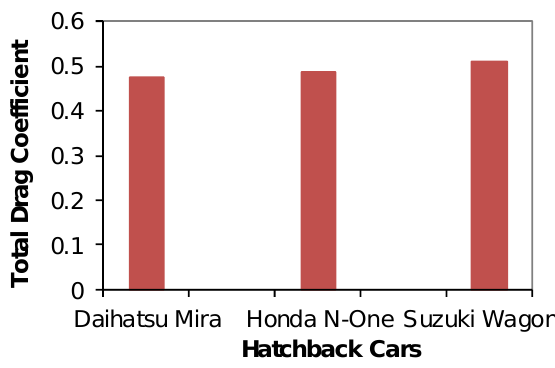
Fig. 14. Frontal areas calculated in SolidWorks